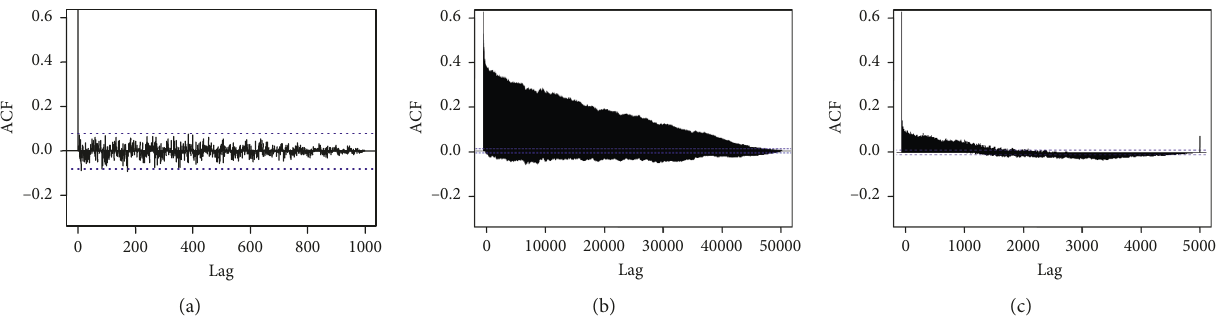
Figure 5: Auto-correlation factor analysis of different traces. B is the ACF plot of majority of predictors in our traces. (a) Random walk trace. (b) Moderate predictability. (c) Limited